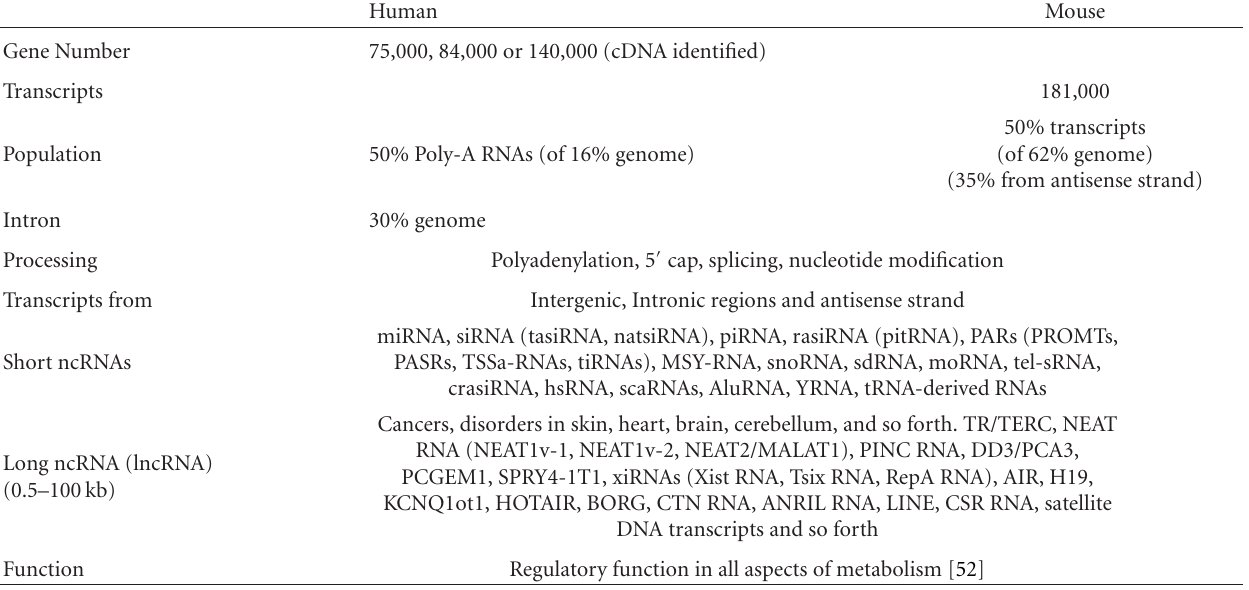
Table 4: Paradoxical characteristics of ncRNAs in humans and mice [50, 51]. The excessive number of transcripts than anticipated for 25,000 genes indicates that the ncRNAs which were not detected due to scarce abundance have been detected by more sensitive methods. Some of these characteristics are